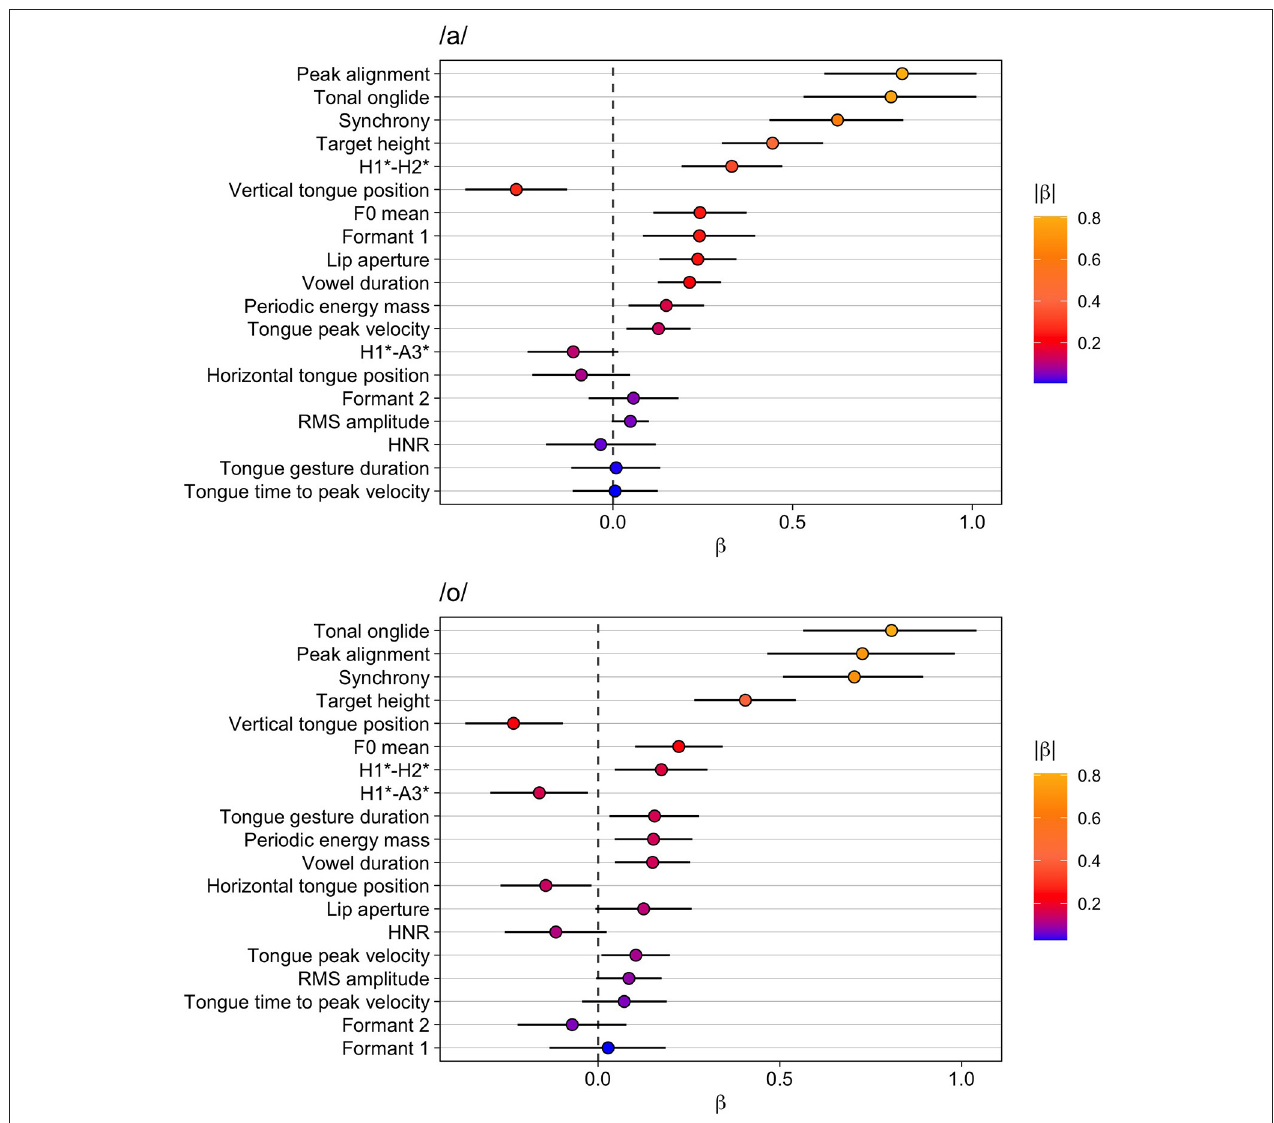
FIGURE 3 | Modeling results for broad vs. contrastive focus. Top: vowel /a/, bottom: vowel /o/. The whiskers indicate the 90% Credible